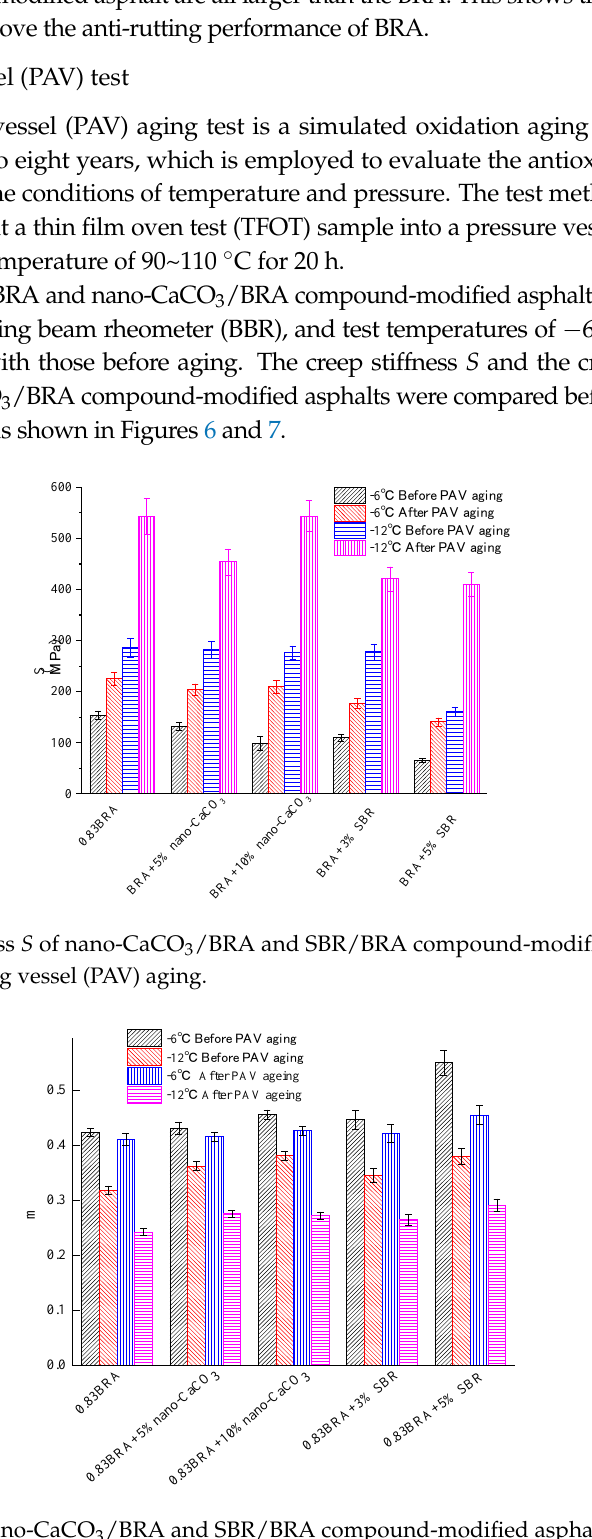
Figure 7. m value of nano-CaCO 3 /BRA and SBR/BRA compound-modified asphalt before and after pressure aging vessel (PAV) aging.